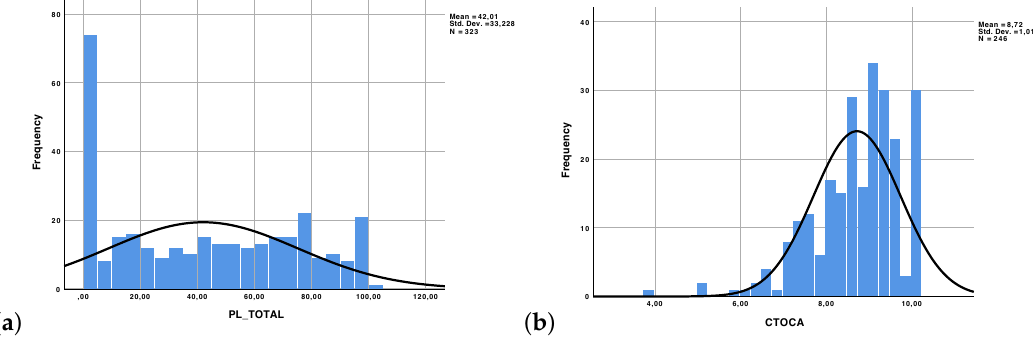
Figure 7. Histogram of ( a ) frequencies of the progress across all the lab activities ( PL _ TOTAL , for 323 students) and ( b ) final grade on a [0, 10] scale ( CTOCA , for the 246 students who actually carried out the final